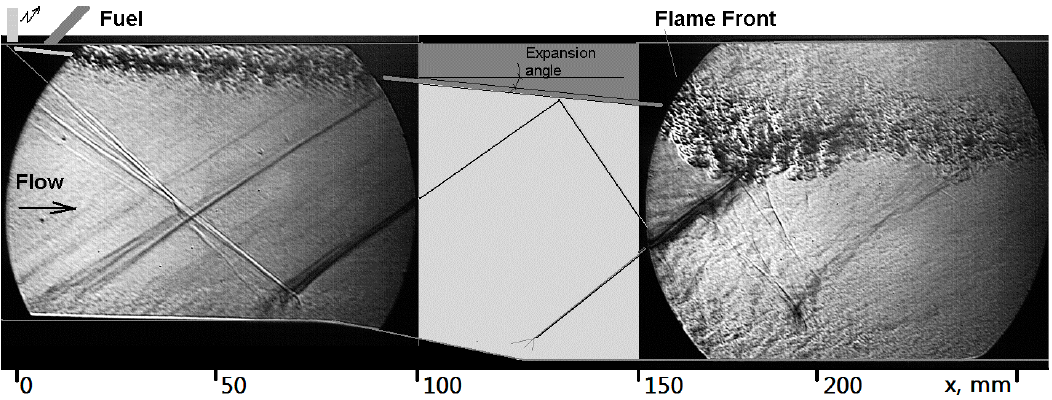
Figure 11. Schlieren image illustrating the flow structure in the test section at combustion, scheme 1, ṁ C2H4 = 1.3 g/s.